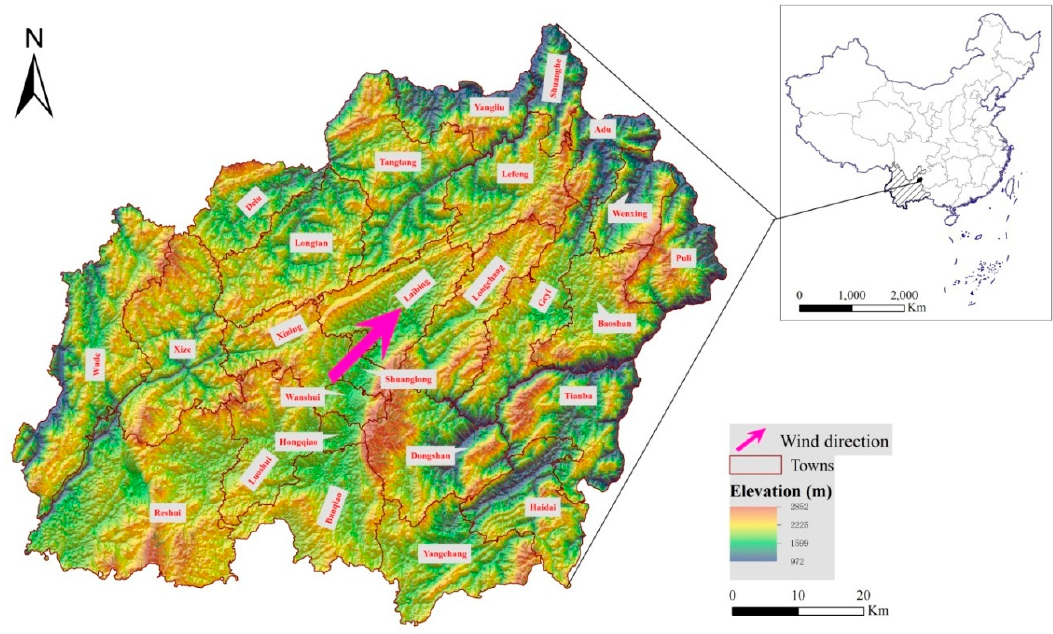
Figure 1. Illustration of the study area and basic topographic information.